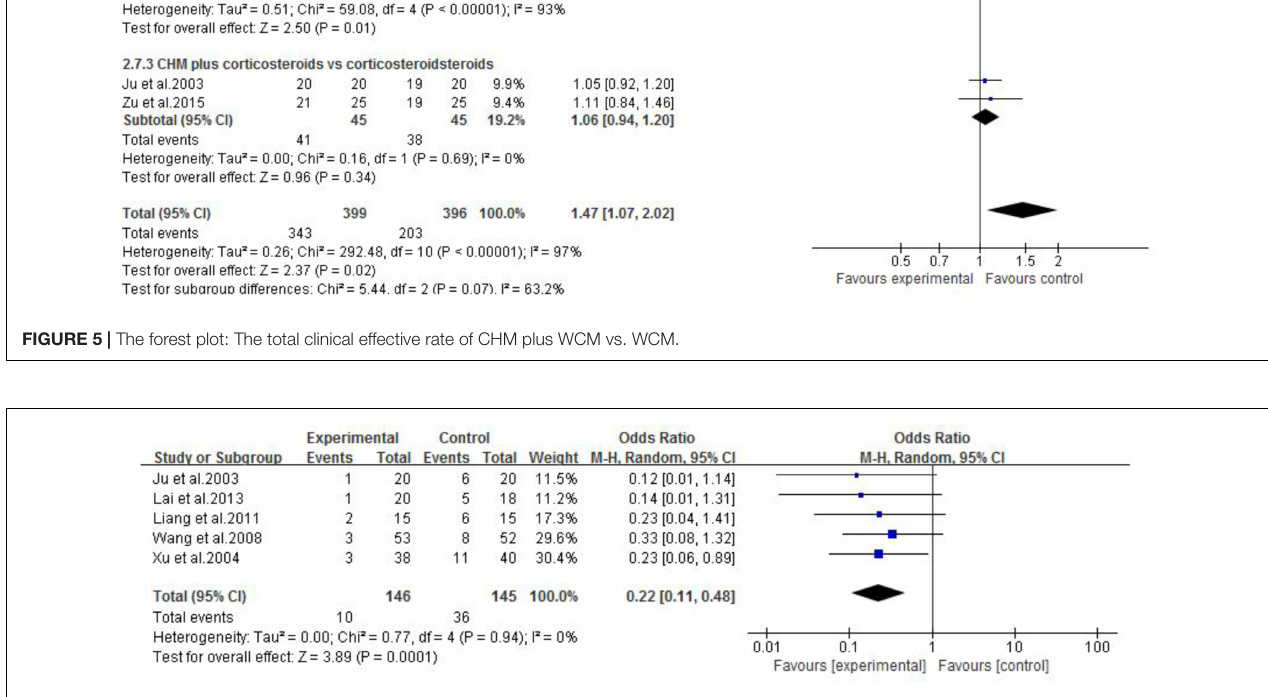
FIGURE 6 | The forest plot: Relapse rate after follow-up of CHM plus WCM vs. WCM.